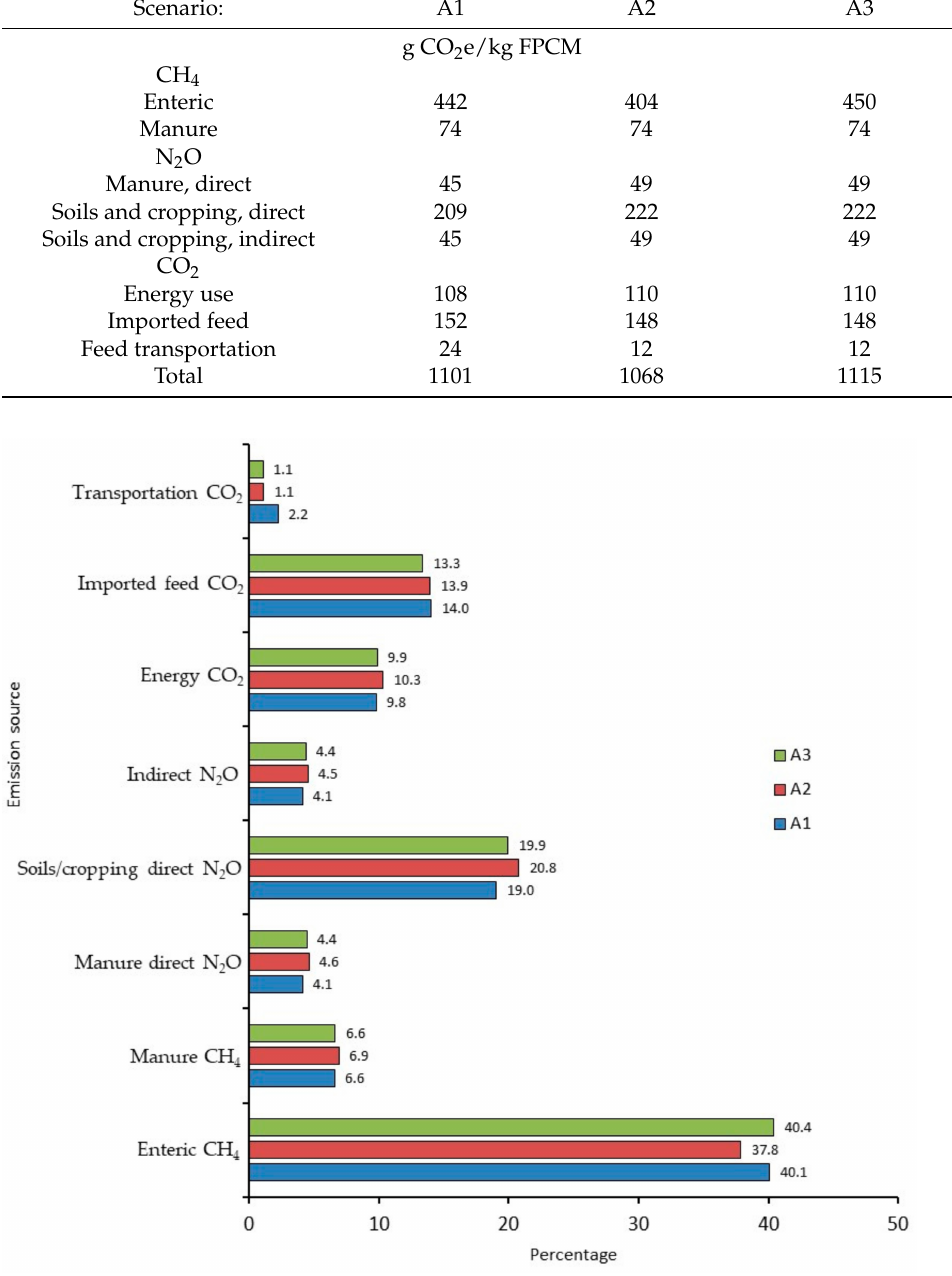
Figure 4. Greenhouse gas proportions of kg CO 2 /kg FPCM for a dairy farm in Alberta using soybean meal (SBM) or canola meal (CM) in the diets of lactating cows. The scenarios were as follows: (A1) SBM from ON, (A2) CM from SK with enteric CH 4 mitigation effect, and (A3) CM from SK without enteric CH 4 mitigation